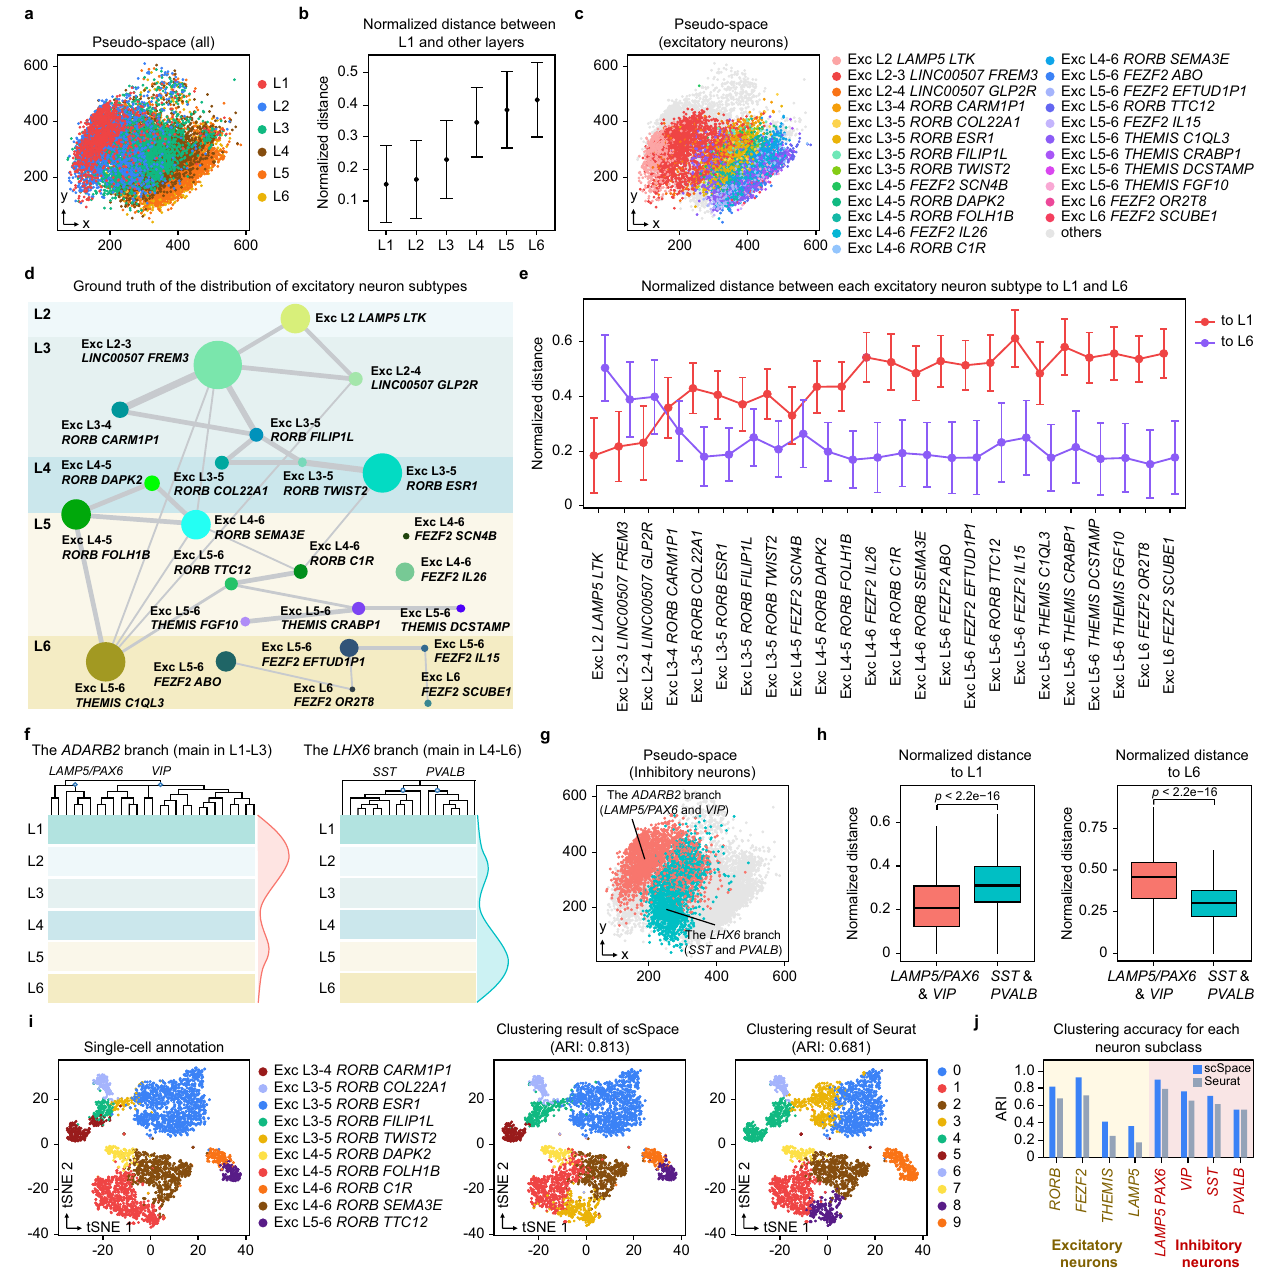
Fig. 4 | Recovering the spatial order of the excitatory/inhibitory neuron sub- typeswithscSpace.a Thereconstructedpseudo-spaceofhumanMTGsnRNA-seq data. b NormalizedpairwisedistancebetweencellsfromL1todifferentlayers.Data are presented as the median±SD. The number of data points for the error bars from left to right are 579,426, 2,300,488, 3,747,708, 3,094,576, 3,936,008, and 2,901,972,respectively. c Spatialdistributionofexcitatoryneuronsubclassesinthe pseudo-space. All other subclasses are labeled as “ others ” . d Schematic of the average layer position for each excitatory neuron subclass. e Normalized pairwise distancebetweendifferentexcitatoryneuronsubclassestoL1(red)andL6(purple). Data are presented asthe median±SD.The numberof data points (to L1) from left to right are 873,712, 2,457,584, 182,920, 301,280, 164,628, 172,160, 100,068, 1,536,528, 186,148, 936,120, 836,052, 26,900, 172,160, 370,144, 179,692, 158,172, 57,028, 83,928, 337,864, 60,256, 401,348, 1,653,812, 20,444, and 55,952, respec- tively;thenumberof datapoints (toL6)from left to rightare 2,189,964,6,159,948, 158,490, 755,160, 412,641, 431,520, 250,821, 3,851,316, 466,581, 2,346,390,